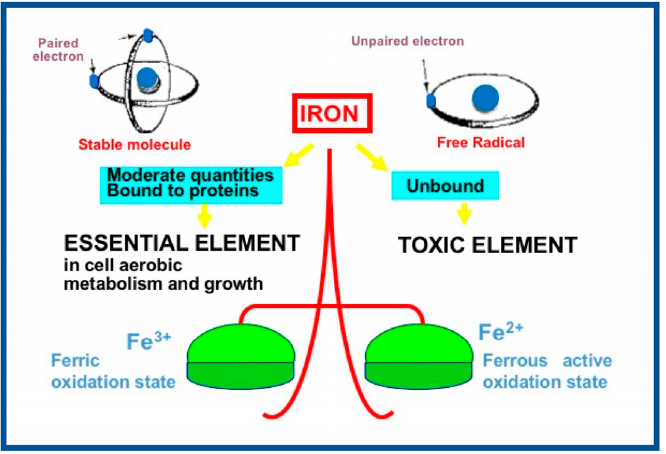
Figure 2. Schematic representation of iron redox state. Iron is a versatile and highly reactive element. Having two common valences, ferrous iron Fe 2+ and ferric iron Fe 3+ , it has access to a wide range of redox (oxidation/reduction) potential.